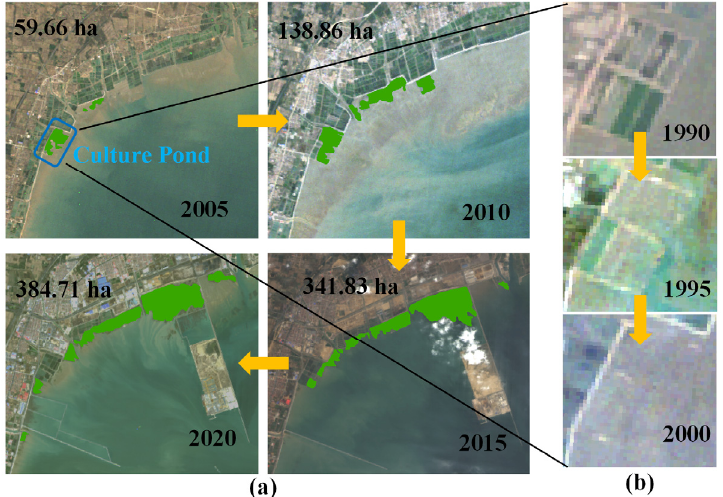
Figure 15. Landsat RGB images. Green is S. alterniflora . ( a ) The distribution area of S. alterniflora in Ganyu Port from 2005 to 2020. ( b ) The demolition process of artificial culture pond (blue rectangular frame) from 1990 to 2000.